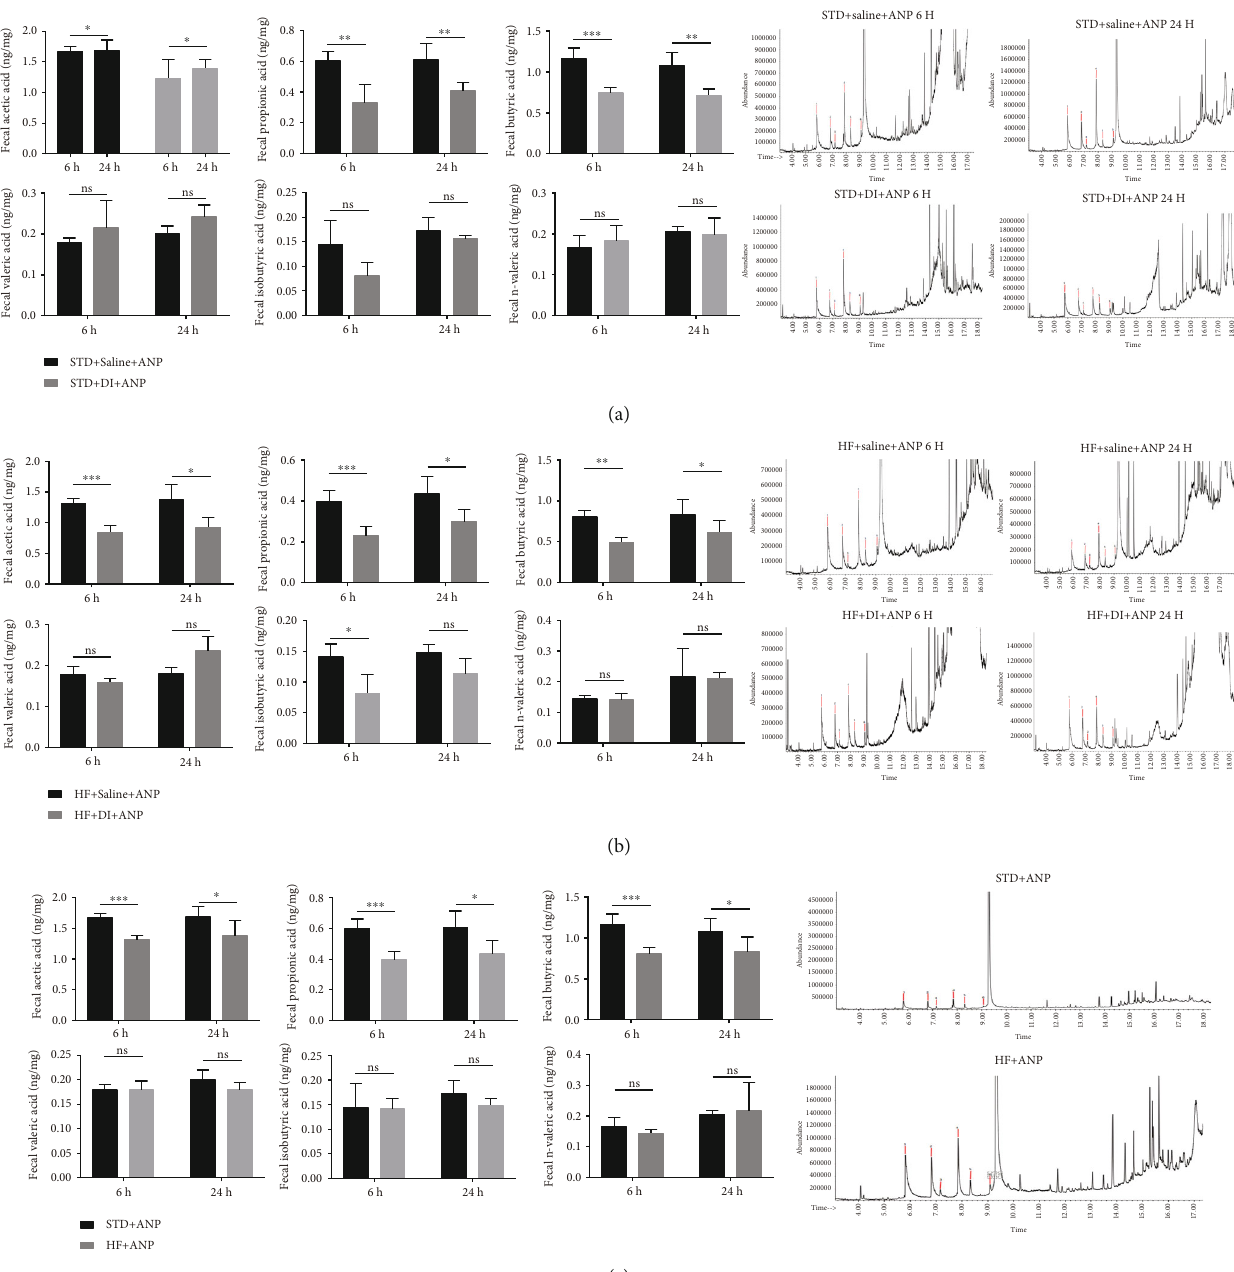
Figure 3: Fecal SCFAs levels as detected by gas chromatography-mass spectrometry. (a) E ff ects of dithizone on short-chain fatty acids in rats on standard diet followed by retrograde sodium taurocholate infusion. (b) E ff ects of dithizone on short-chain fatty acids in rats on high-fat diet followed by retrograde sodium taurocholate infusion. (c) E ff ects of high-fat diet on short-chain fatty acids in rats followed by retrograde sodium taurocholate infusion. ∗ p < 0 : 05 , ∗∗ p < 0 : 01 , ∗∗∗ p < 0 : 001 , Student ’ s t -test. Results were expressed as the mean ± SD ( n = 5